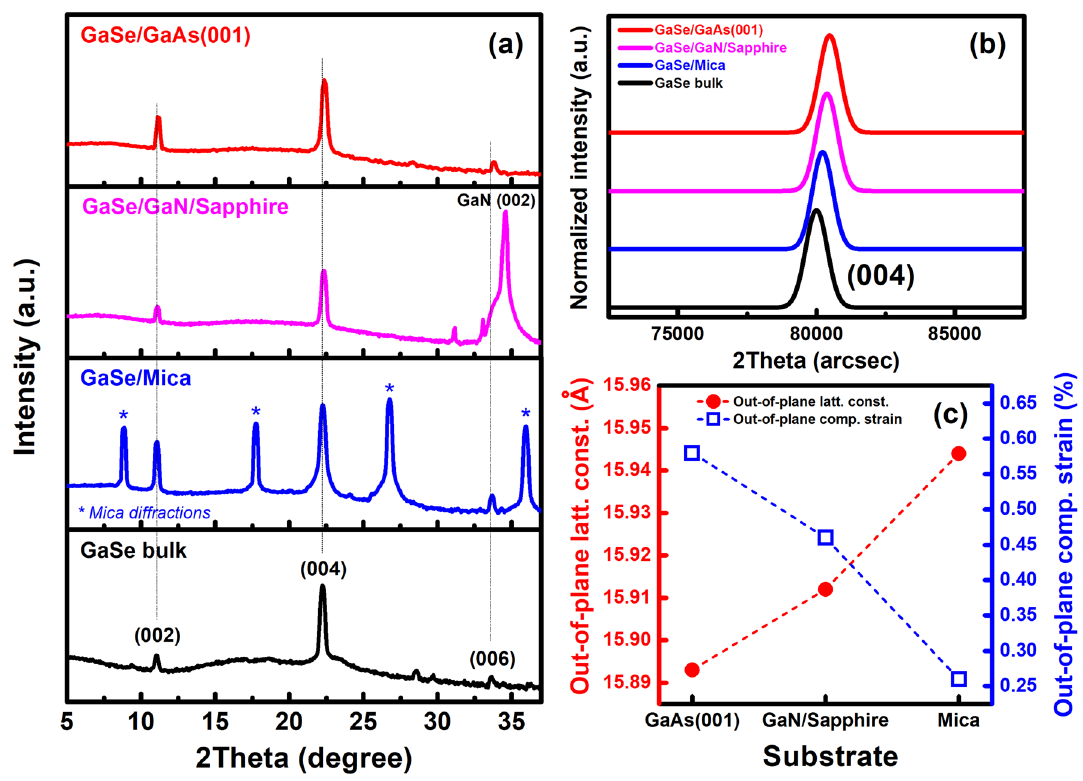
Figure 4. Long-range ( a ) and near (004) peak ( b ) XRD 2θ-scans of GaSe bulk and GaSe films grown on various substrates. ( c ) Out-of plane lattice constants and compressive strains of GaSe